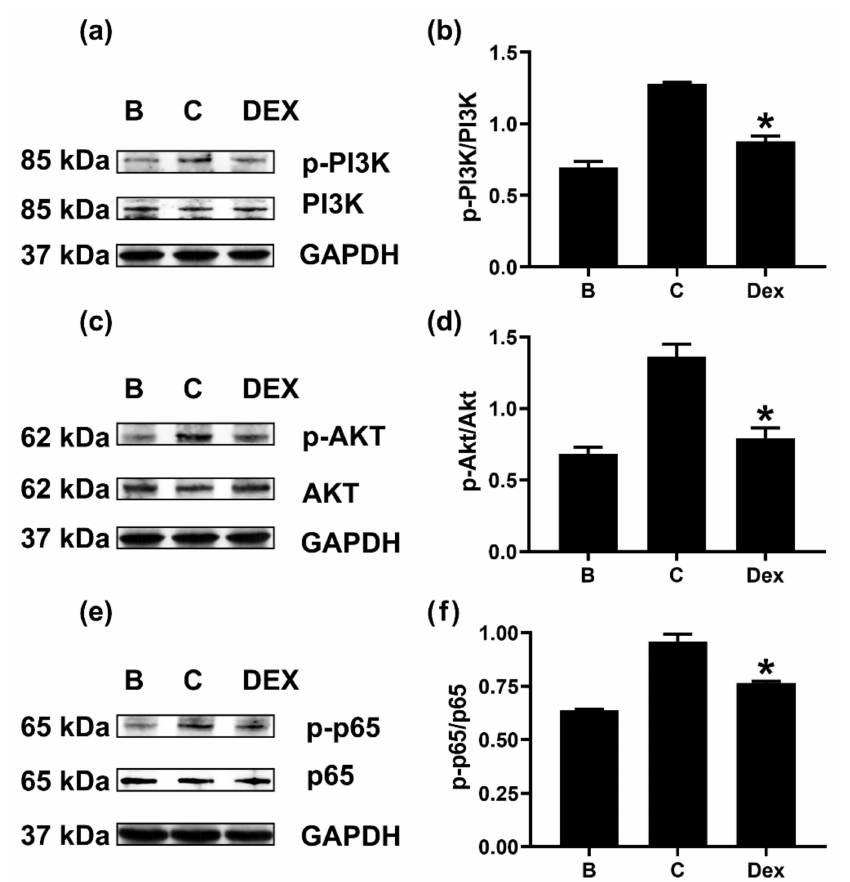
Figure 5. Effects of Dex on the phosphorylations of PI3K, Akt, and NF- κ B in neutrophil-like dHL-60 cells. ( a , c , e ) dHL-60 cells (5 × 10 6 ) were pretreated with Dex (100 nM) for 1h and then stimulated with GM-CSF (5 ng/mL) for 15 min (PI3K), 30 min (Akt), or 60 min (p65). ( b , d , f ) The protein expression levels were quantitated by densitometry. B—PBS-treated and unstimulated cells; C—PBS- treated and GM-CSF-stimulated cells; Dex—Dex-treated and GM-CSF-stimulated cells. Data are presented as the mean ± S.E.M. of three independent experiments. * p < 0.05 vs. the PBS-treated and GM-CSF-stimulated